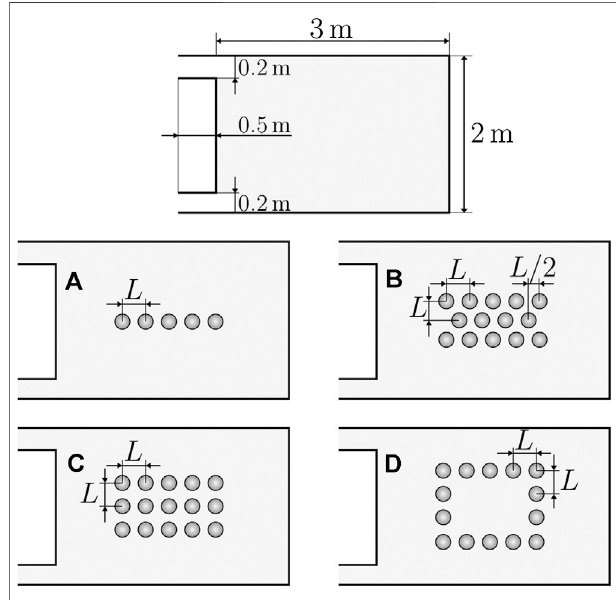
FIGURE 4 | Schematic representation of the furnace geometry and four canonical tube arrangements assessed in the parameter study. Con fi gurations: line (A) , staggered (B) , aligned (C) , and rectangle (D) .